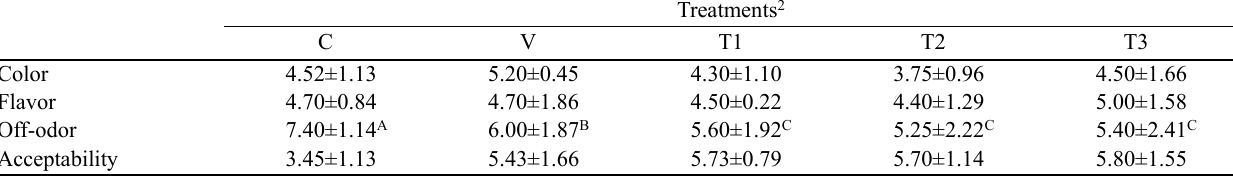
Table 5. Sensory evaluation 1 results for uncooked pork patties mixed with VAL ethanol extract on the third day of storage Treatments 2 C